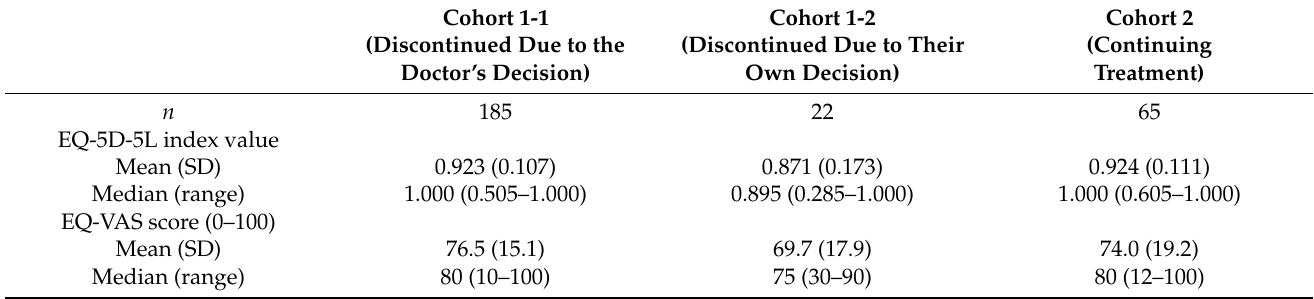
Table 5. Distribution of EQ-5D-5L.